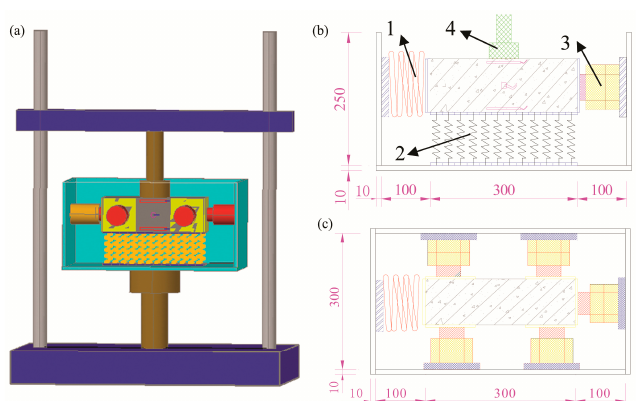
Figure 6. Schematic of the fatigue test.